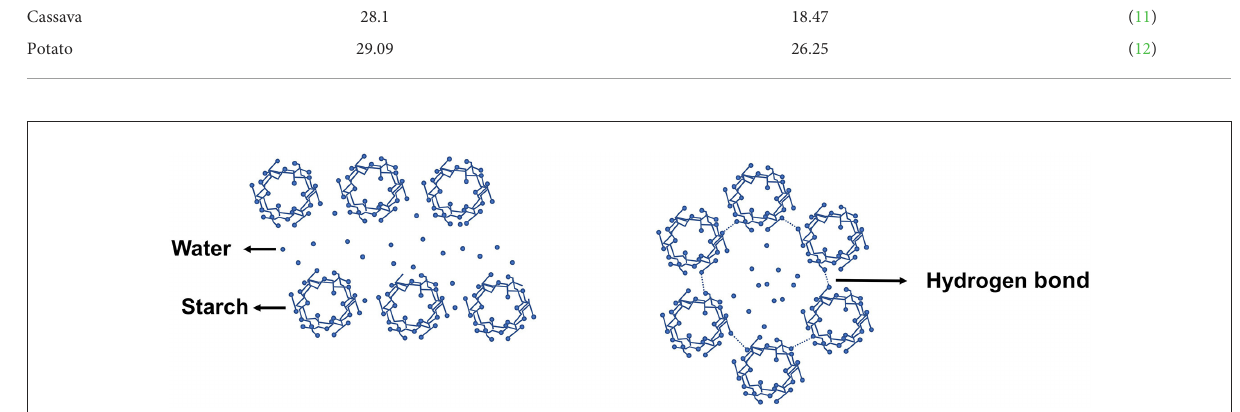
FIGURE2 Crystal pattern of natural starch (type-A on the left and Type-B on the right ).